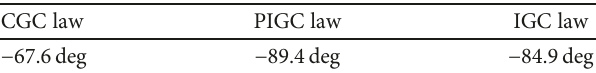
Table 6: Impact angle under the three control laws against a maneuvering